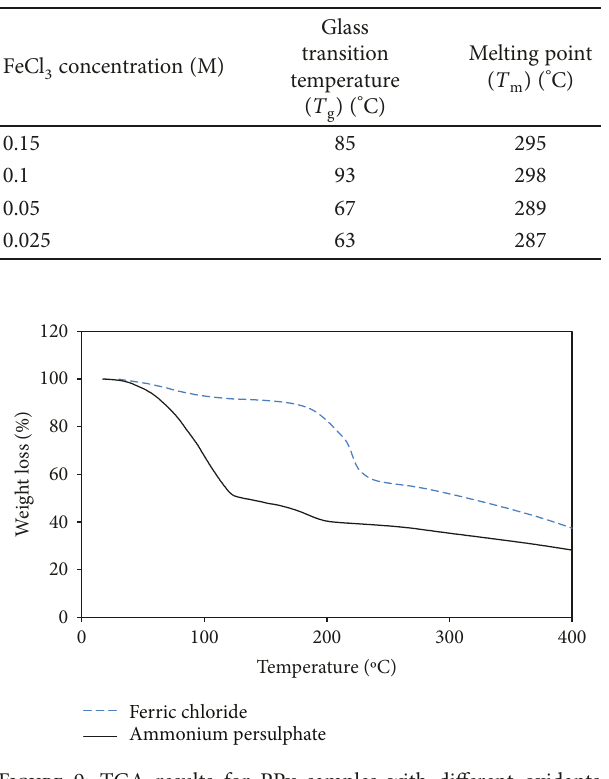
concentrations. 3